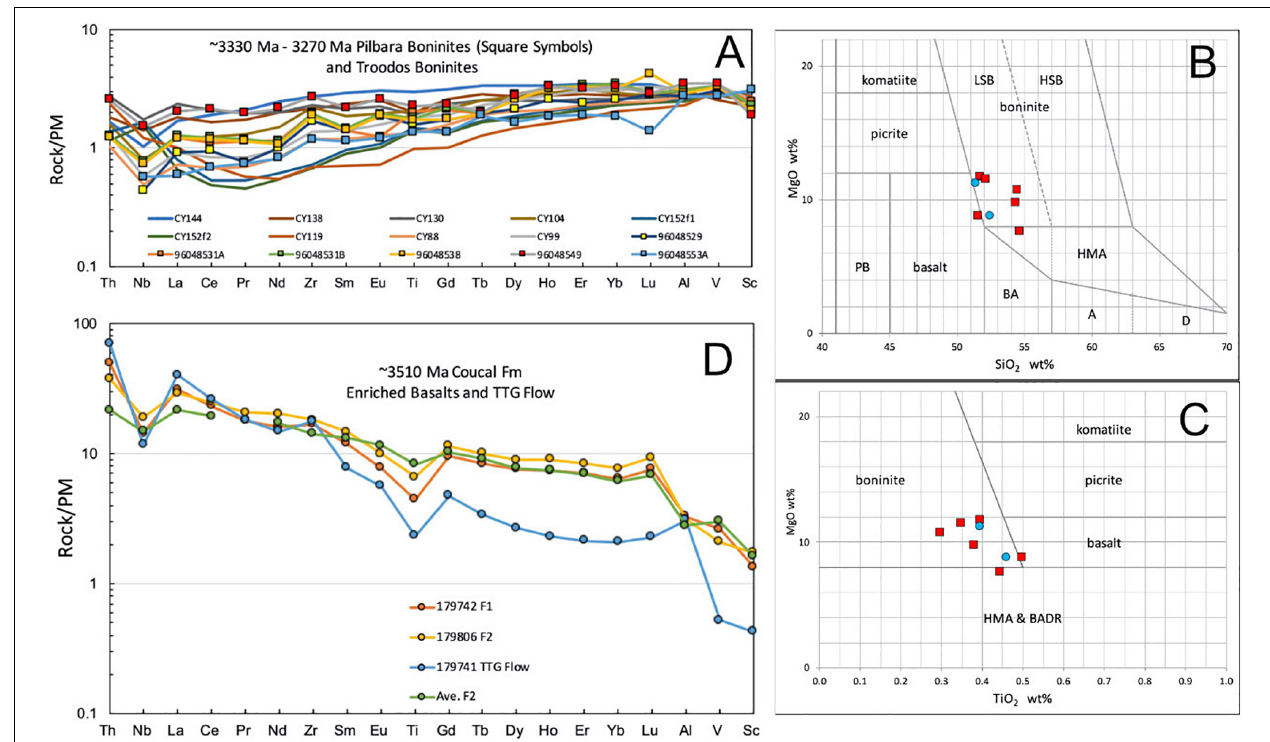
FIGURE 5 | Geochemical data for selected rocks of the Pilbara Supergroup (from Smithies et al., 2005, 2009). (A) Primitive mantle-normalized multi-element plots for Paleoarchean boninites and boninitic rocks from the Sulfur Spring Group compared to plots for Troodos boninites. Sample numbers from Smithies et al. (2005) and Osozawa et al. (2012). (B,C) Pilbara samples from the Sulfur Spring Group (red squares) and Euro Basalts (blue circles) plotted on the discrimination plots of Pearce and Reagan (2019). LSB, low-silica boniites; HSB, high-silica boninites; PB, picro-basalt, BA, basaltic andesite, HMA, high-magnesium andesite; A, andesite; D, dacite. (D) ∼ 3510 Ma rocks of the lowermost preserved volcanic rocks of the Pilbara Supergroup showing basalts with enriched characteristics and a tonalite–trondhjemite–granodiorite (TTG) flow. Sample numbers from Smithies et al. (2009). Primitive Mantle normalizing values from McDonough and Sun